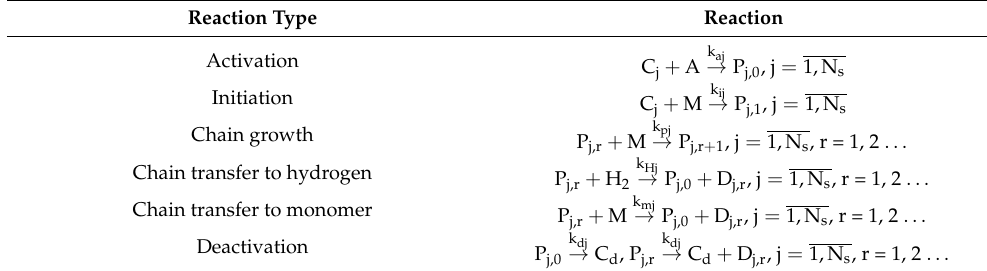
Table 1. Kinetic scheme of the liquid-phase polymerization of